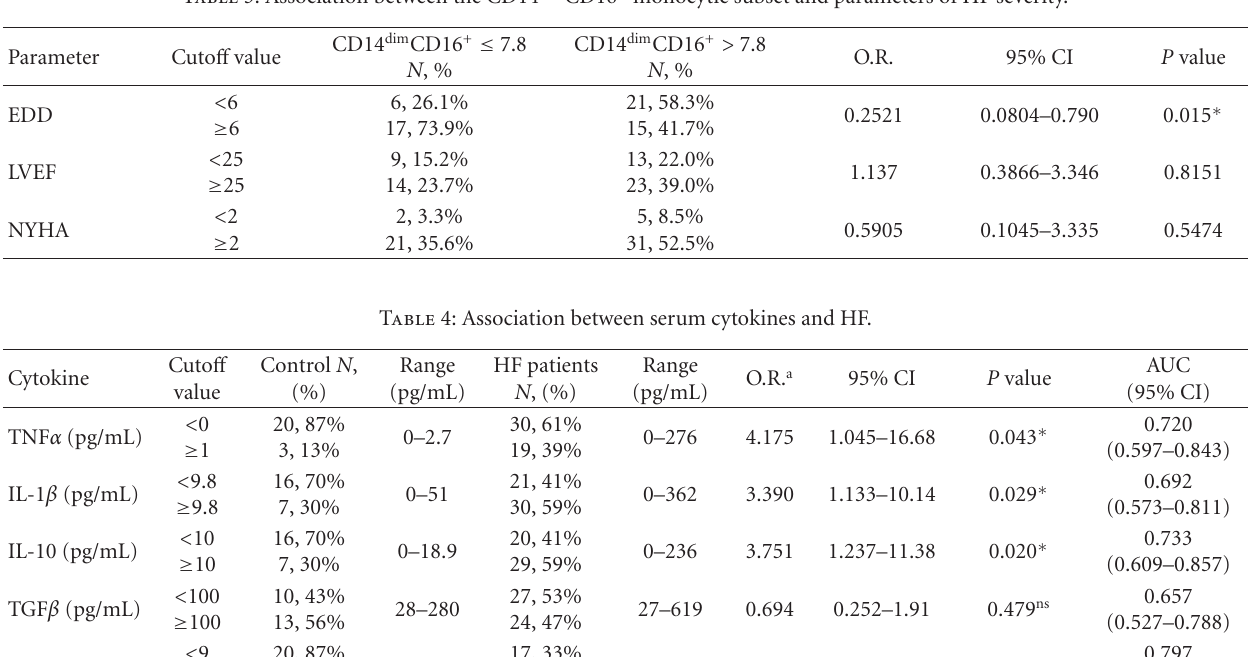
Table 3: Association between the CD14 dim CD16 + monocytic subset and parameters of HF severity.